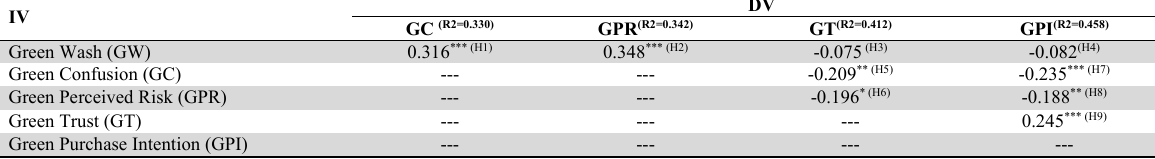
Results of Direct Impact Hypotheses